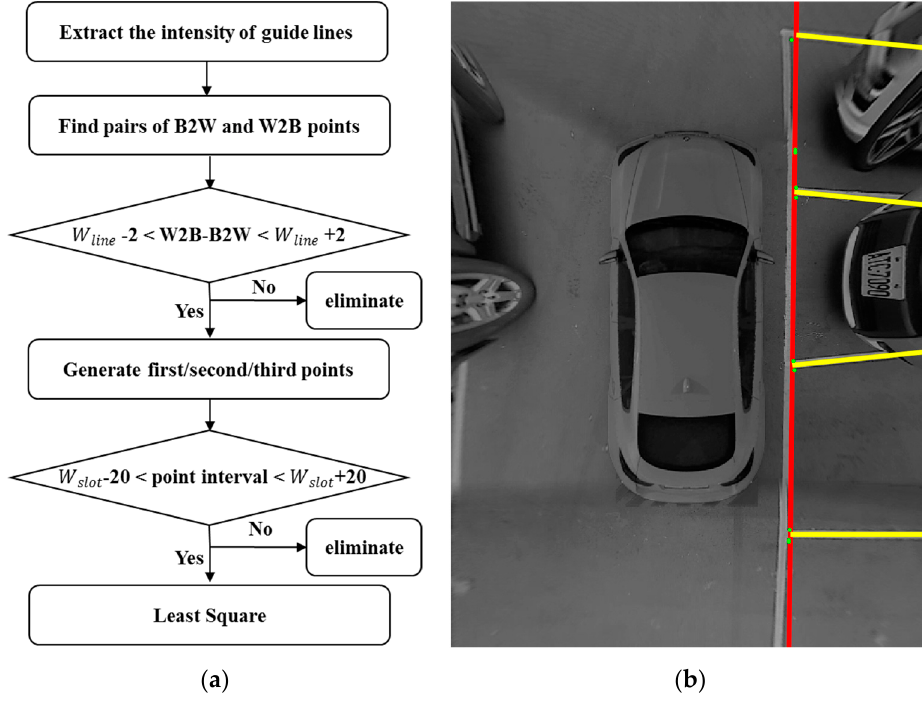
Figure 13. Divider line recognition. ( a ) Algorithm; ( b ) Results.